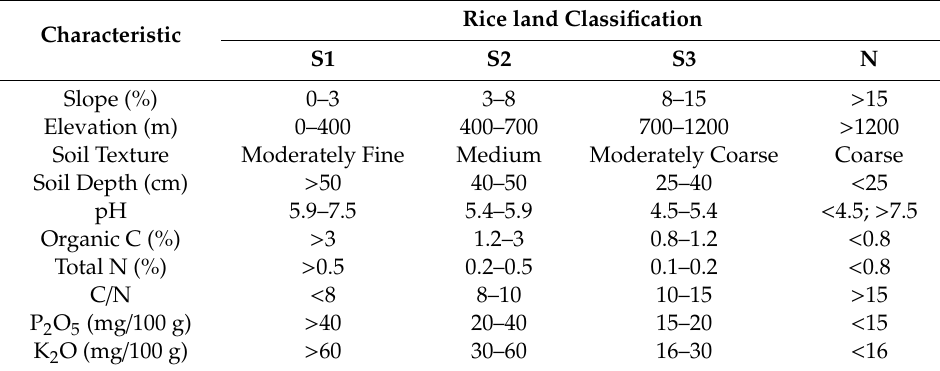
Table 2. The rice land suitability classification